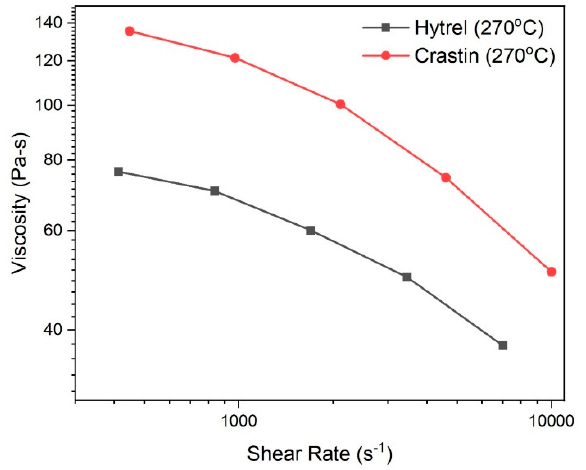
Figure 1. Shear rate vs. Viscosity curves for Hytrel and Crastin.